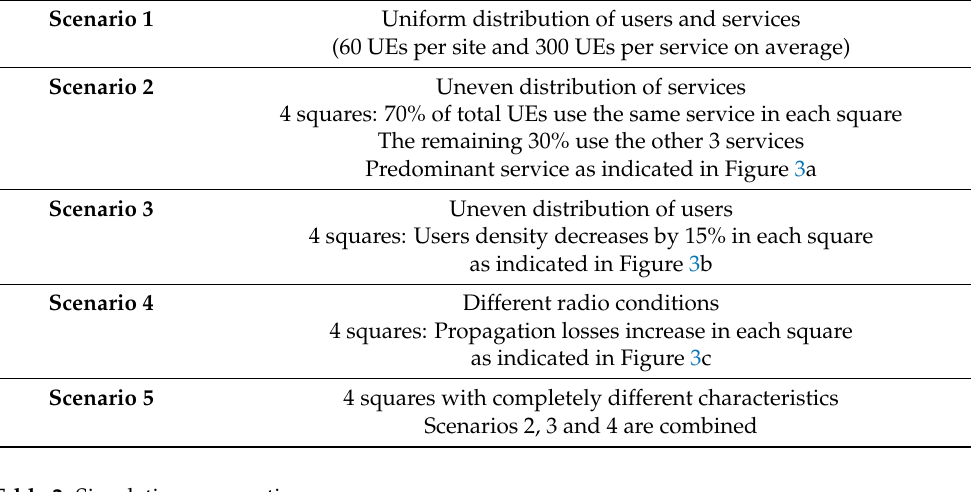
Table 2. Simulation